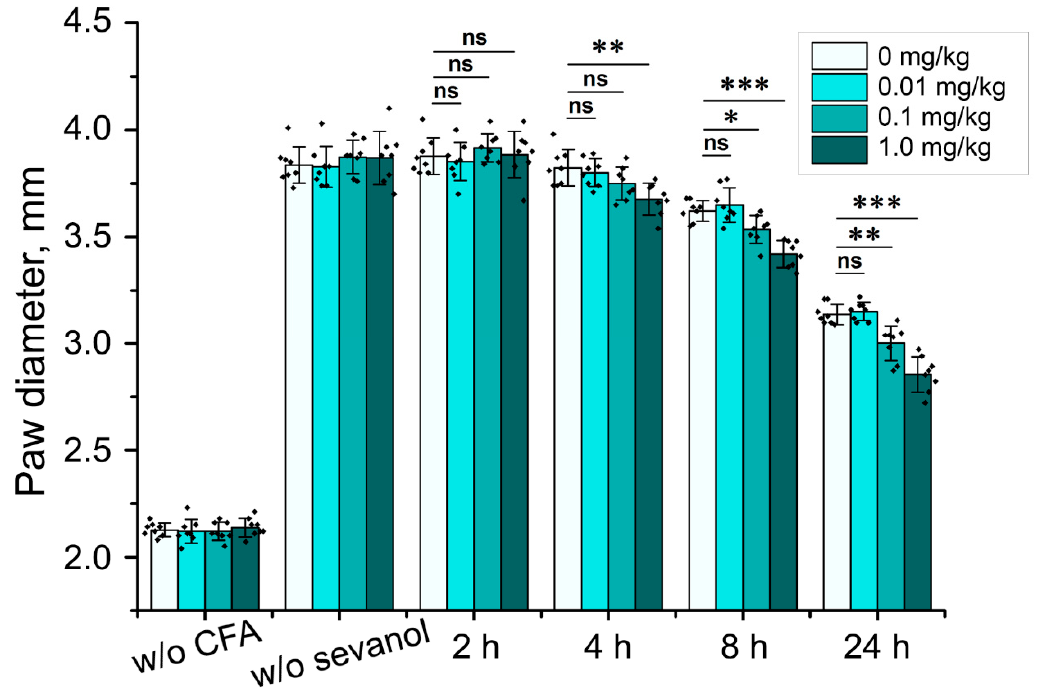
Figure 6. Anti-inflammatory effect (oedema reduction) of sevanol after per os (p.o.) administration. Paw oedema induced by CFA injection was estimated before the CFA and sevanol administration, and 2, 4, 8 and 24 h after the p.o. administration of sevanol at different doses. Results are presented as the mean ± SD ( n = 8). * p < 0.05, ** p < 0.005, *** p < 0.001 versus the saline group (ANOVA followed by a Tukey’s test).